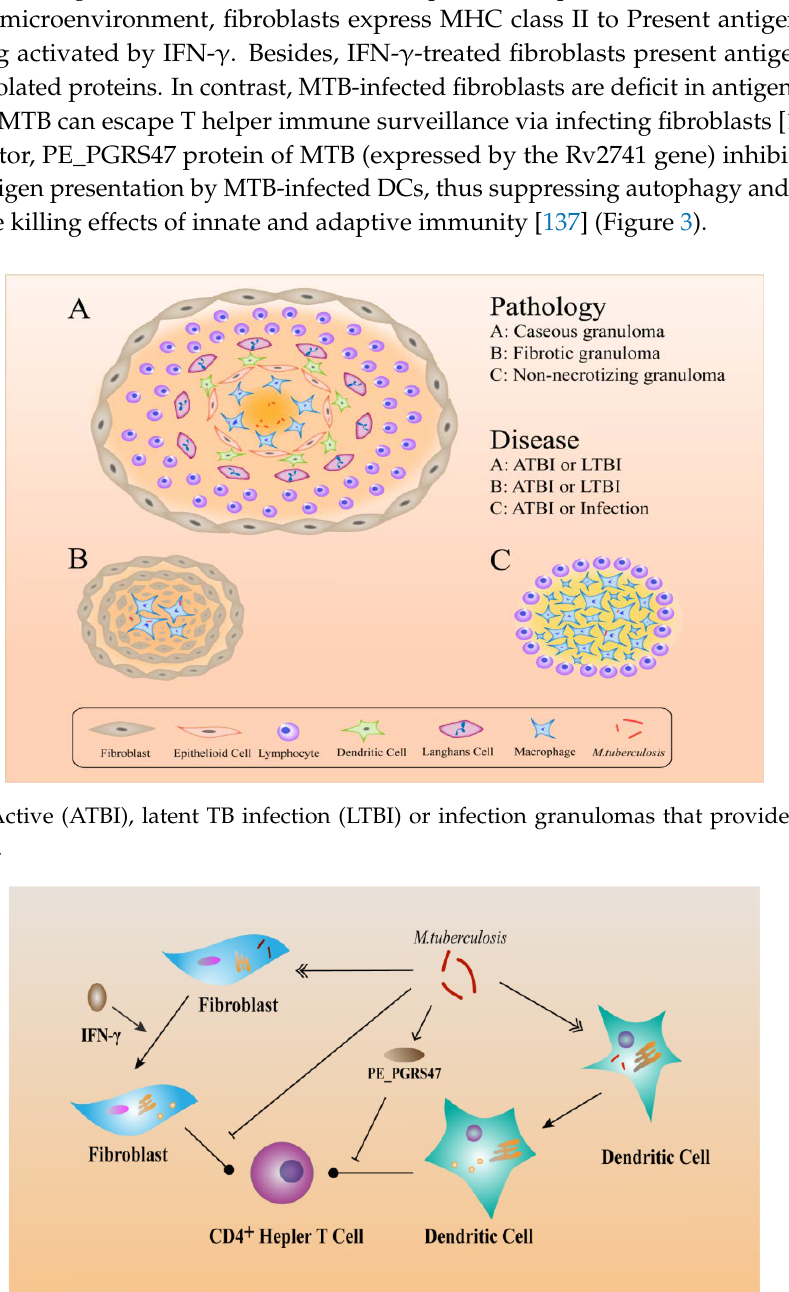
Figure 3. Relationship between MHC class II and M. tuberculosis evasion. As non-professional antigen-presenting cells, fibroblasts also present antigen derived from the processing of heat-killed MTB in addition to presenting peptides and isolated proteins. But MTB-infected fibroblasts are unable to present antigen from the bacteria. Peptide-loaded MHC class II molecules activate T cells to generate an immune response against MTB and this action occurs in the plasma membrane. However, PE_PGRS47 expressed by MTB can inhibit the presentation of MHC class II